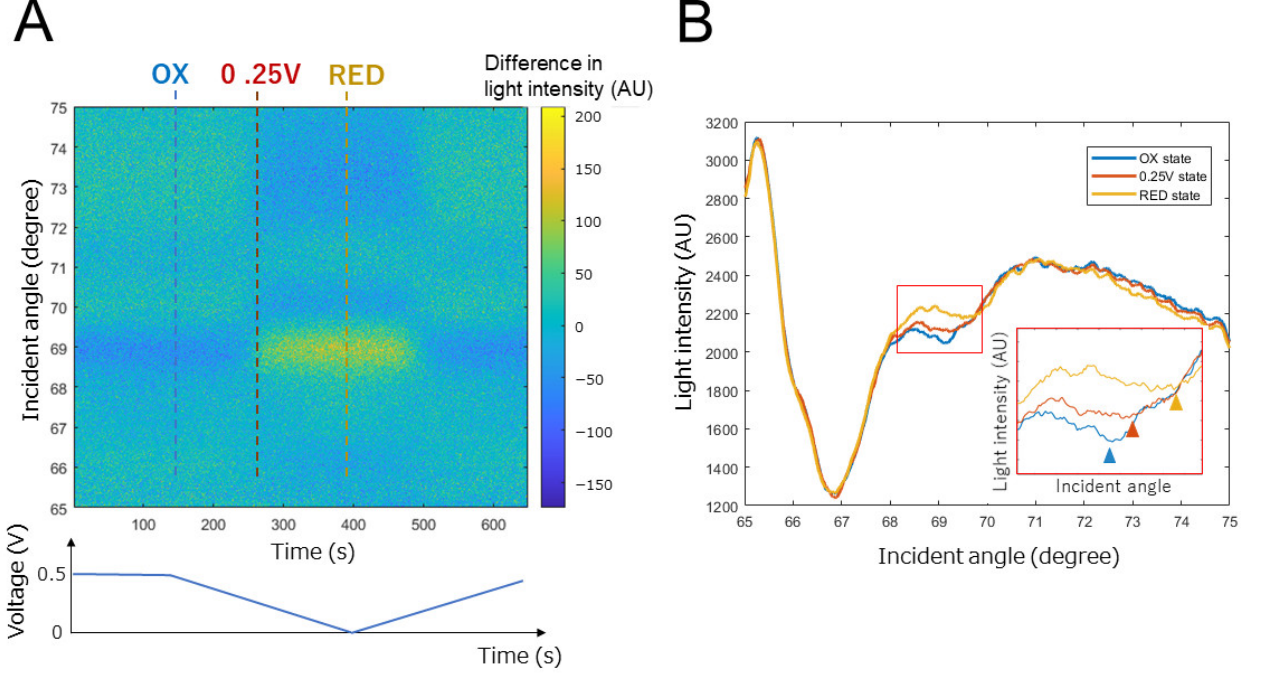
Figure 3. SPR measurements on electrodes subjected to potential sweep. ( A ) Time-course of SPR curve. Light intensity was standardized by zscore. Ox: oxidase state of osmium, 0 V: state with a charge of 0 V, RED: redox state of osmium. ( B ) Changes in SPR curve due to changes in the state of osmium. The inset is an enlarged view of the SPR curve between incident angles of 68 and 70 degrees. The triangles are the secondary dips in each SPR curve.